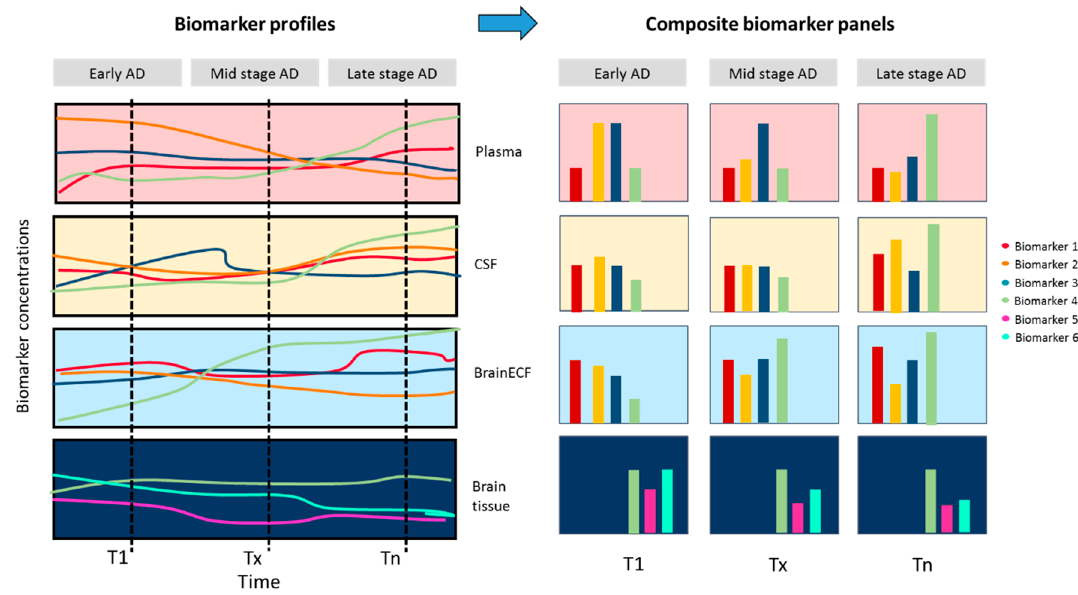
Figure 4. Anticipated approach to study and understand the processes in AD progression. Longitudinal, multiple-biomarker, multiple-body-site measurements in AD animals (and their control littermates—not shown here) should be able to reveal processes and their interdependencies in AD and in normal ageing as stage (T1, Tx, Tn)-dependent “composite biomarker panels”, leading to insights that are AD-specific to be targeted as therapy.